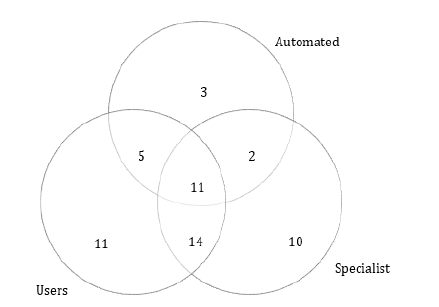
Figure 1. Venn diagram - Distribution of coverage of problems on the web platform